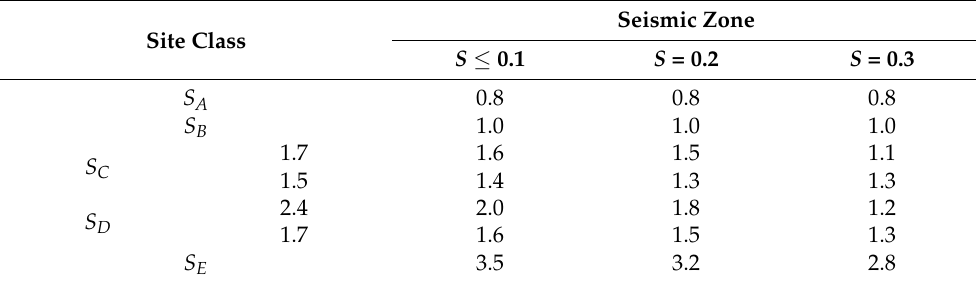
Table 3. Soil amplification parameter at one second, F v .